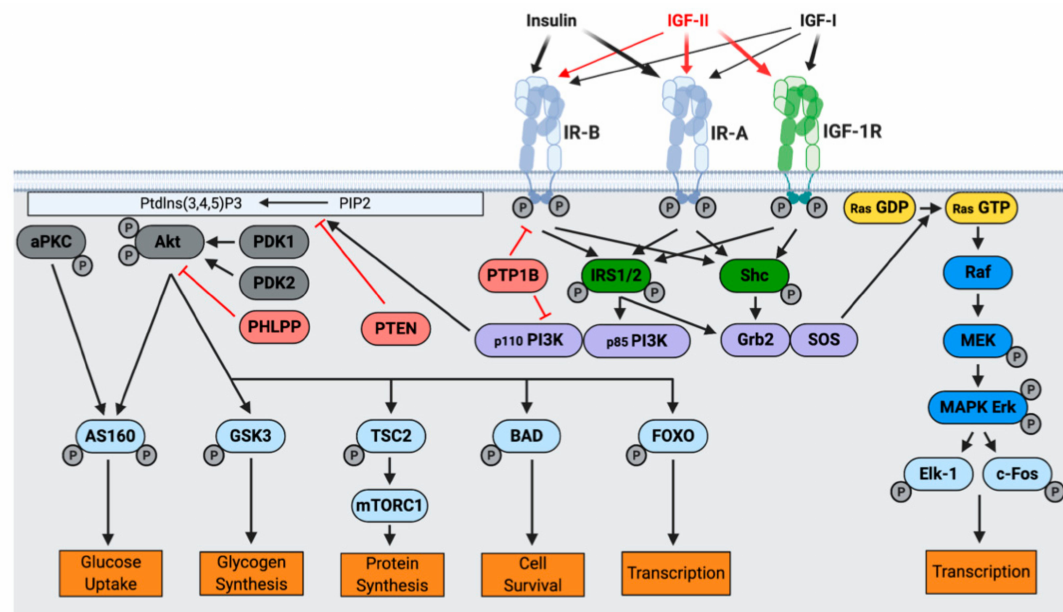
Figure 2. The Insulin and IGF system. Insulin, IGF-I and IGF-II bind with di ff erent a ffi nities to IR-B, IR-A and IGF-1R (indicatd by thickness of arrows). IGF-II binds with high a ffi nity to both IGF-1R and IR-A, and with low a ffi nity to IR-B. Upon receptor binding, a structural change leads to activation of the intracellular tyrosine kinase domain and autophosphorylation (indicated by P). IRS1 / 2 and Shc adapter proteins are recruited and two main signaling pathways are activated: the Akt / PKB and the Ras / MAPK pathways. Metabolic and mitogenic activities are promoted, respectively. (Adapted from: